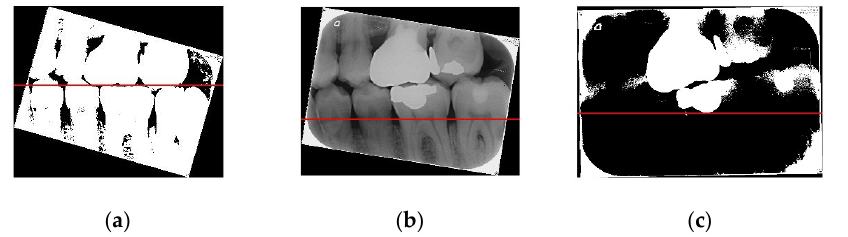
Figure 8. ( a ) Image processed through the Gaussian filter and Otsu’s thresholding, where the red line separates the upper and lower teeth; ( b ) image without any processing, where the red line separating the upper and lower teeth is very imprecise; ( c ) image processed only through Otsu’s thresholding, where the red line separating the upper and lower teeth is also imprecise.